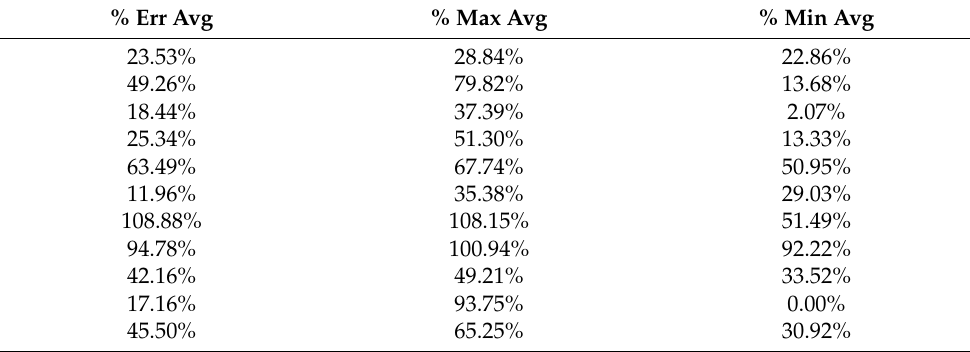
Table A118. Set 2, trials 21–30 data (single 0.5 PR value).